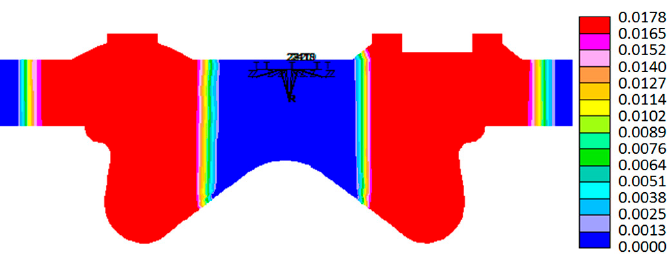
Figure 2. The distribution of CO 2 mass fraction of EGR strati fi cation assigned radically at − 30 °CA